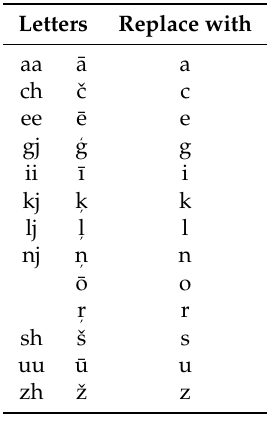
Table 7. Letter substitution rules used for language simplification.